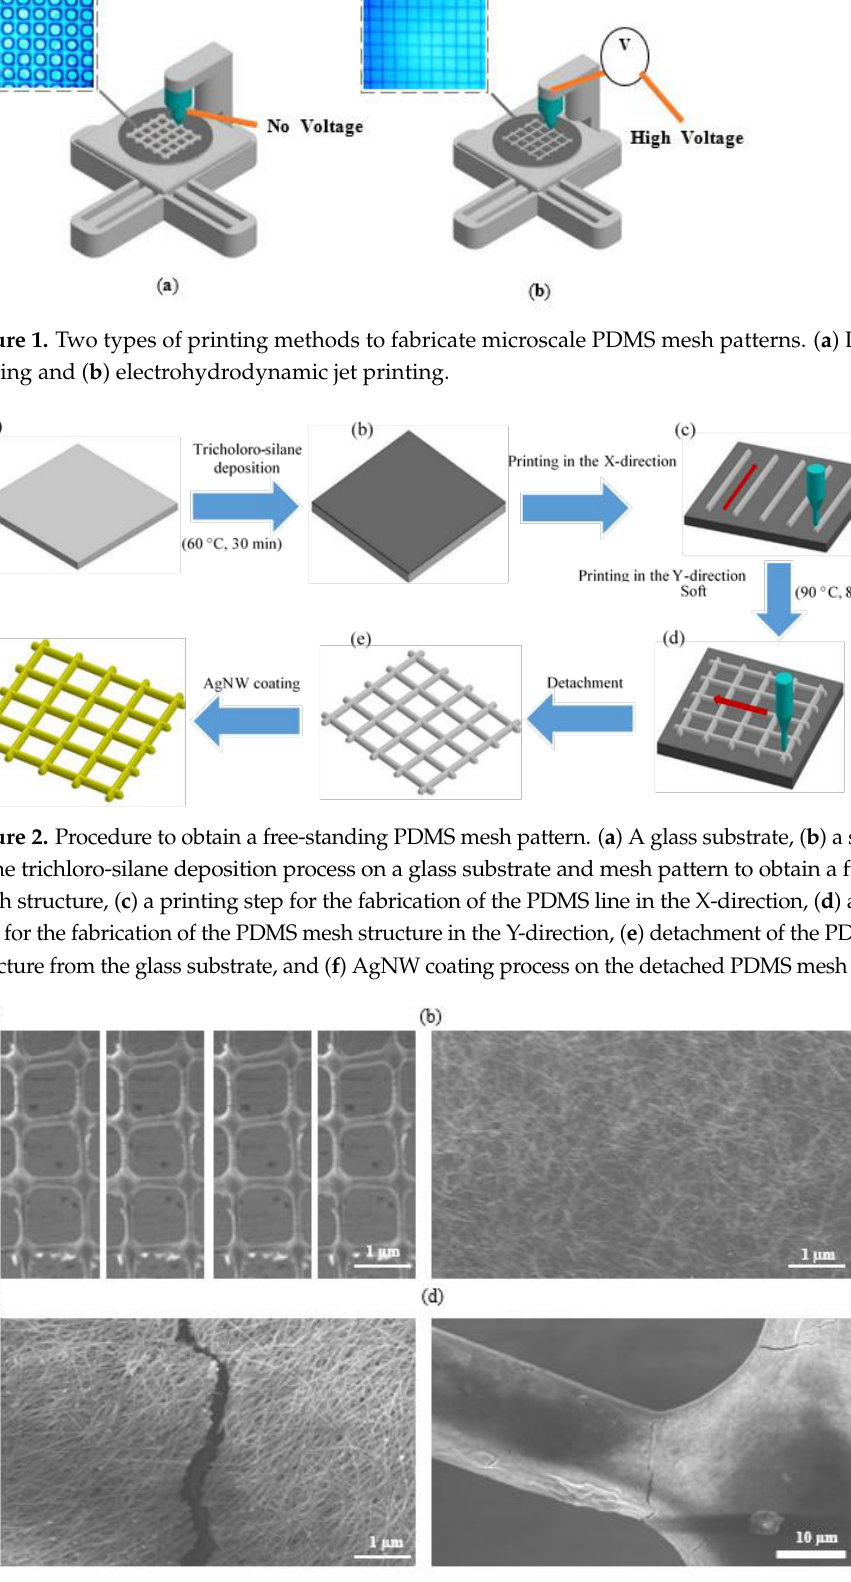
Figure 4. Parametric study of viscoelastic PDMS/xylene elastomer ink. ( a ) Effect of speed on the line width, ( b ) effect of nozzle height on the line width, ( c ) effect of voltage on the line width, and ( d ) I − V curve. Figure 5 shows how a mesh-printed elastomer structure design can be successfully created using direct ink writing and EHD jet printing techniques. The printed mesh struc- ture resolution was low, at approximately 50 µm, and was achieved by direct ink writing, where no electric field effects were applied between the nozzle and substrate (Figure 5a). When we printed liquid PDMS/xylene in the perpendicular direction on the soft-baked transverse pre-patterned elastomer, the liquid PDMS/xylene formed a low-resolution round mesh structure (Figure 5a). The minimum hole size in the direct ink writing exper- iment was approximately 30 µm and the line thickness was around 50 µm, but it was possible to change it further by carefully altering the printing parameters (voltage, speed,